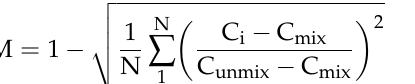
Figure 2. Simulation results with different flow ratios.